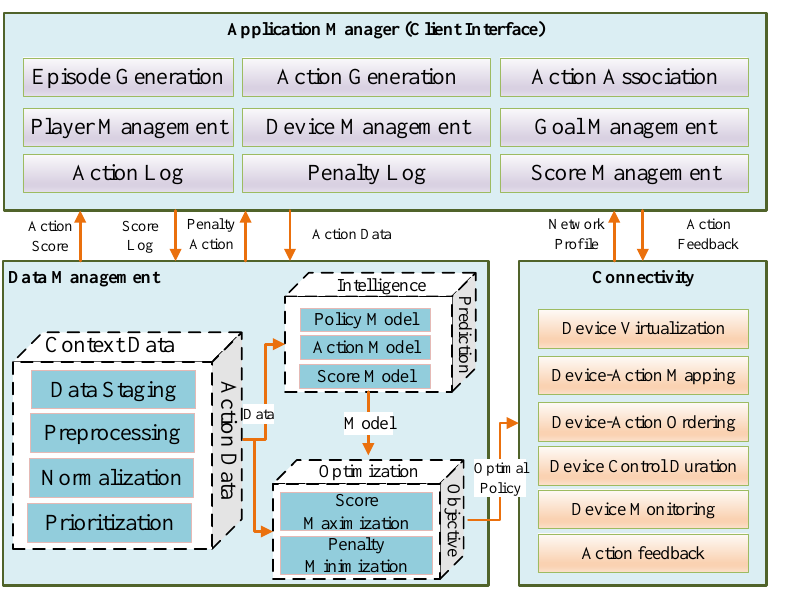
Figure 1. Conceptual architecture of an IoT-enabled serious